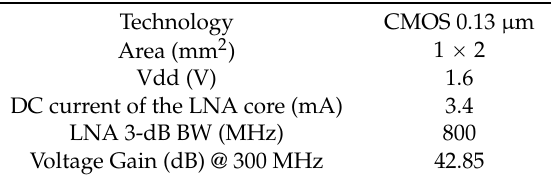
Table 1. CMOS Chip Specifications.